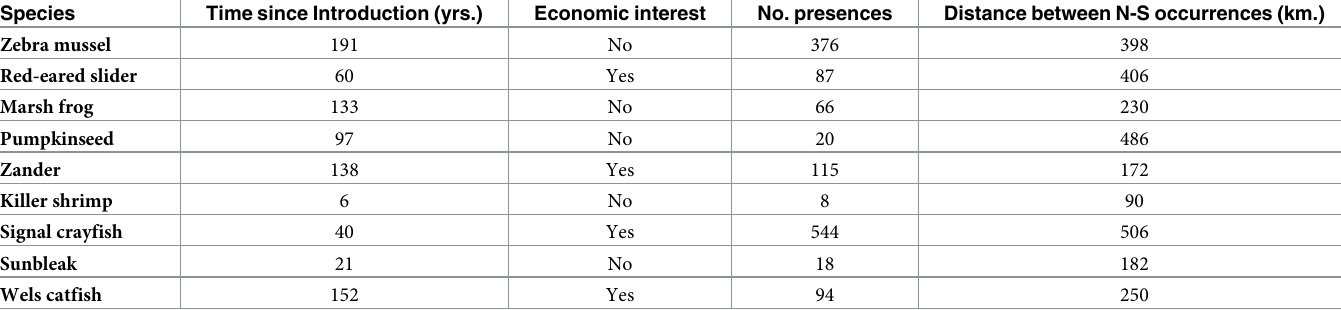
Table 2. Characteristics of the species’ spatial records and their invasion used as predictors to model the overall performance ability of the freshwater invasive Spe- cies Distribution Models. Species Time since Introduction